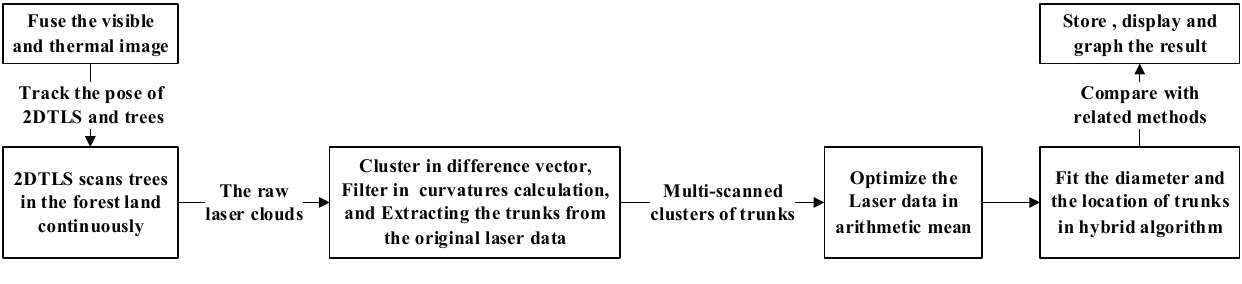
Figure 8. The analysis flow of DBH estimation with 2DTLS data for the harvesting